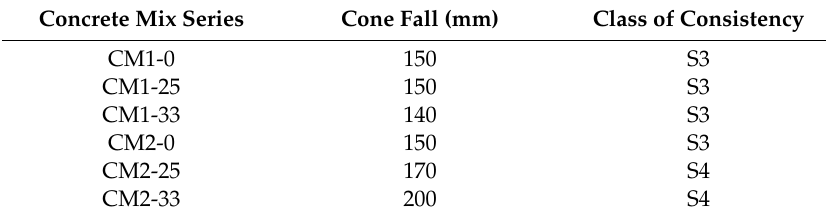
Table 4. Summary of concrete mix consistency testing results.